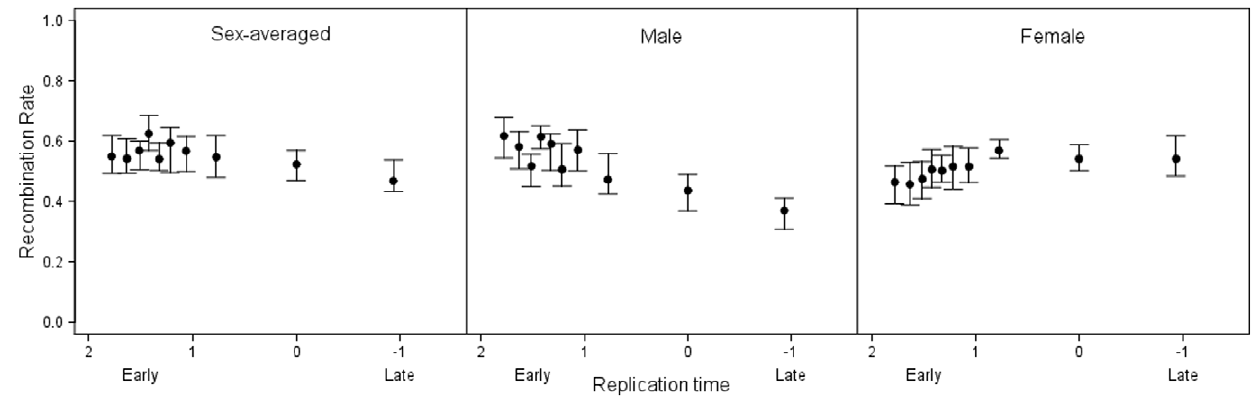
Figure 3. Sex-specific relationships between replication time and recombination rate. Relationships between replication time and sex- averaged, male-specific and female-specific recombination rates. Data shown are mean-smoothed 2 data binned by median replication time where points are the median of each equally sized bin 6 95% confidence intervals.